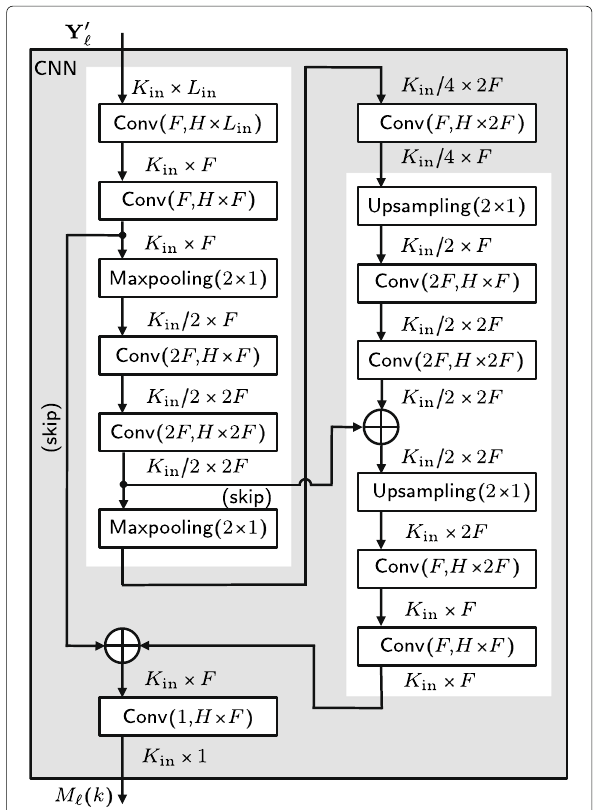
Fig. 2 Topology details of the employed CNN in Fig. 1 (adopted from [48, Fig. 6]). The operation Conv f , h w stands for convolution, with F or 2 F representing the number of filter kernels in each layer, and h w representing the kernel size. The maxpooling and upsampling layers have a kernel size of 2 1 . The stride of maxpooling layers is set to 2. The gray areas contain two symmetric procedures. All possible forward residual skip connections are added to the layers with matched